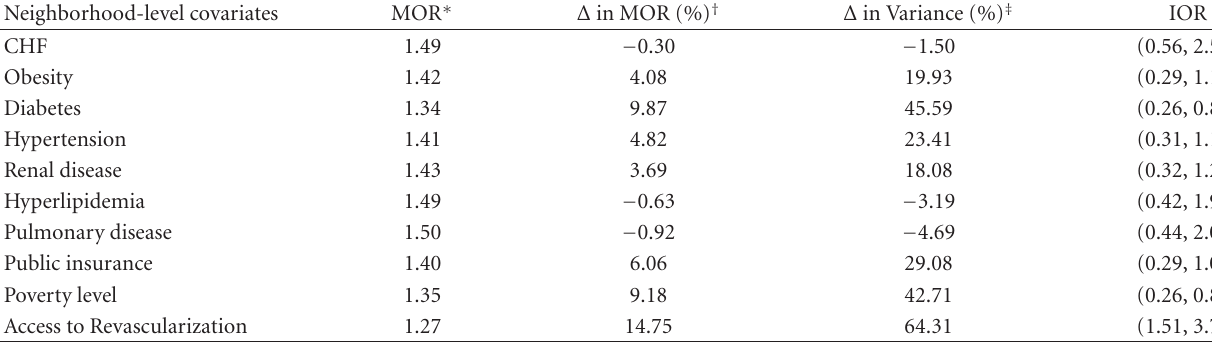
Table 3: Assessment of neighborhood-level covariates (adjusted for selected patient-level covariates as shown in Table 2).